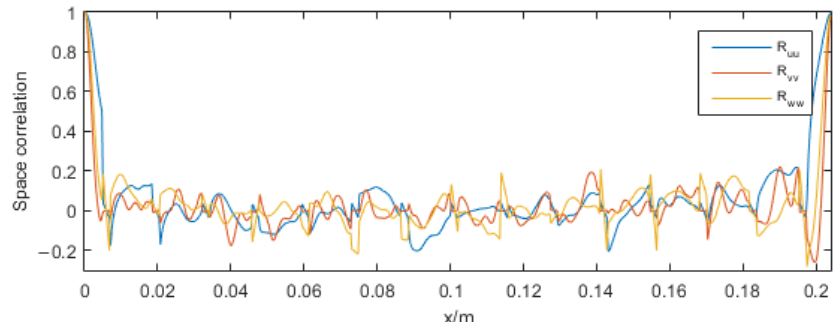
Figure 4. Space correlation along longitudinal direction at y = 1 mm in the prediction model.